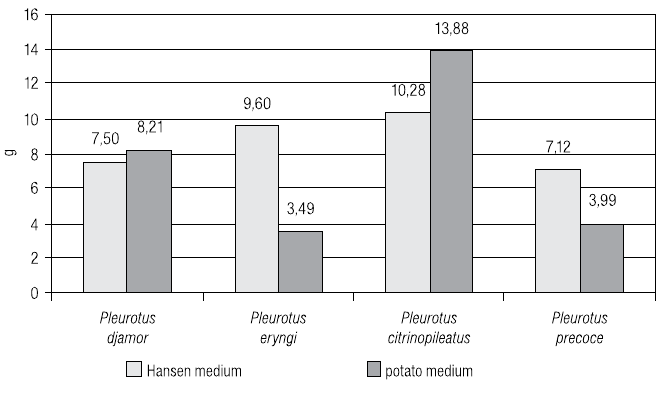
Fig. 1. Fresh mycelium mass in the liquid stationary cultures depending on the medium and oyster genus.